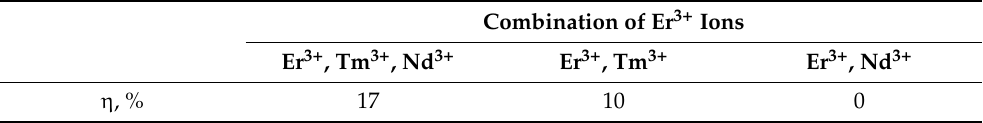
Table 2. Values of energy transfer efficiency for one-, two-, and triple-doped systems with the selective excitation of Er 3+ ions.